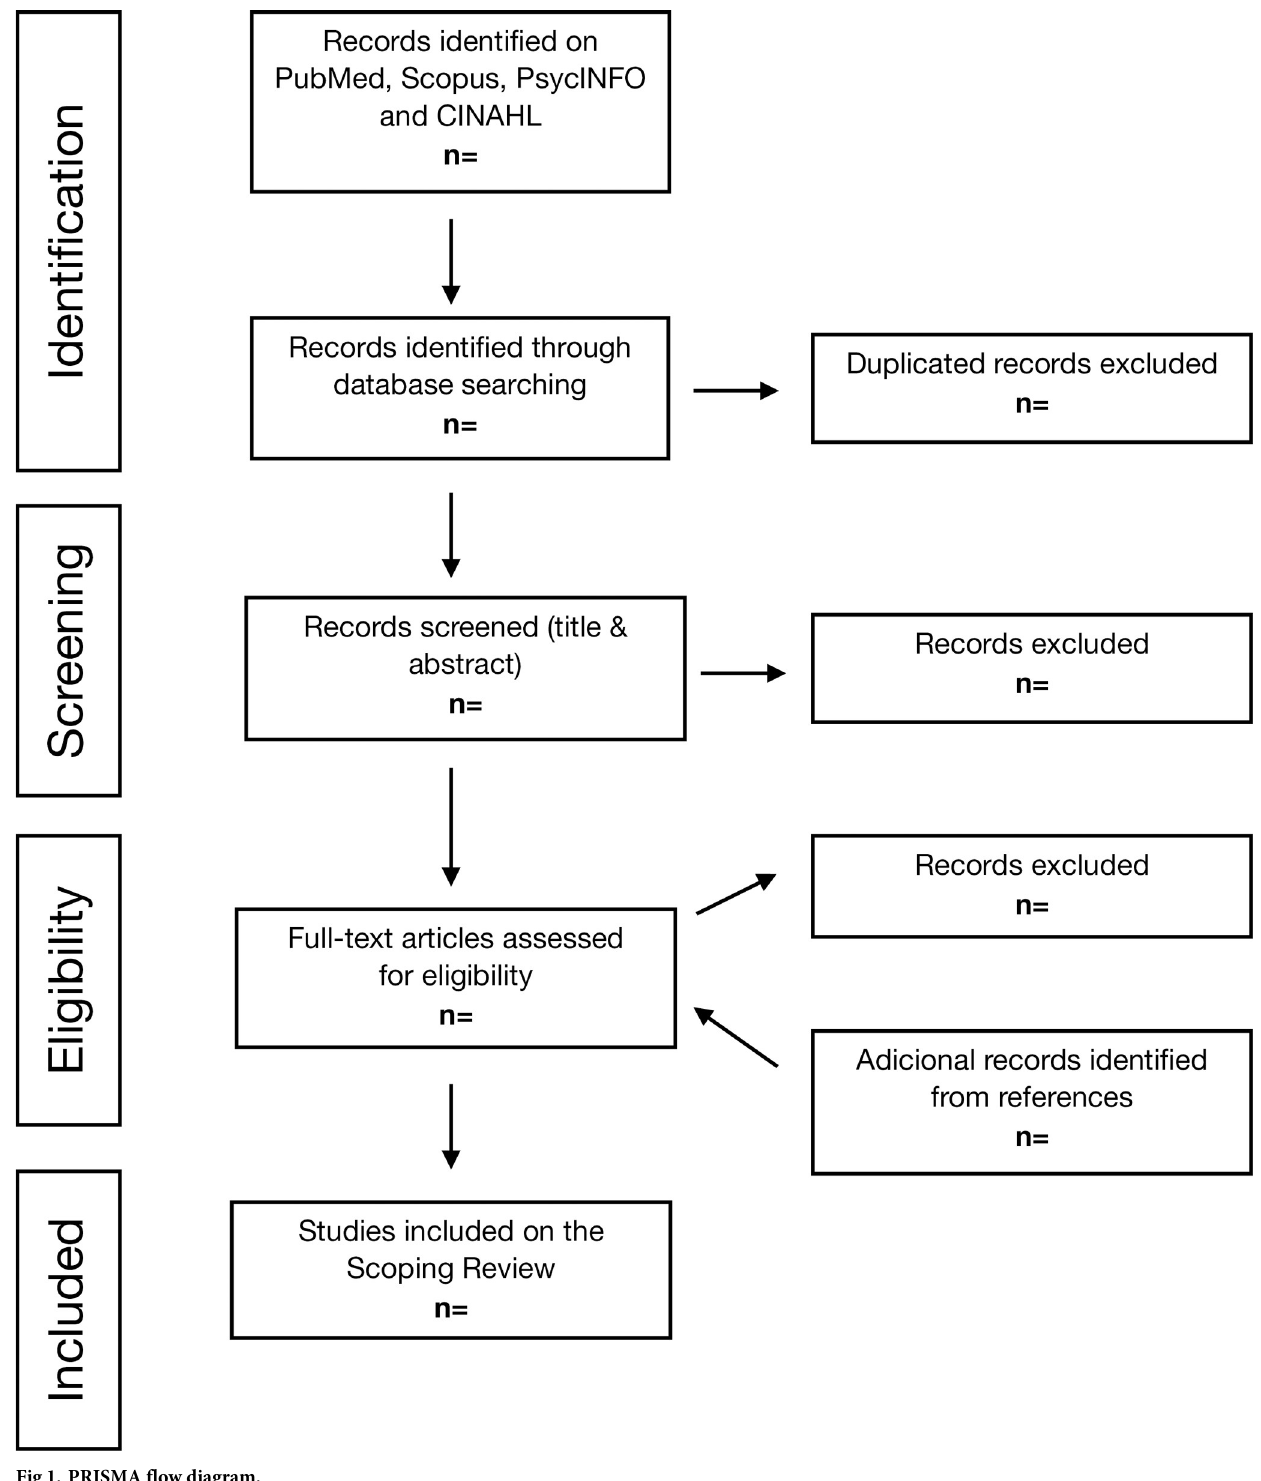
Fig 1. PRISMA flow diagram.